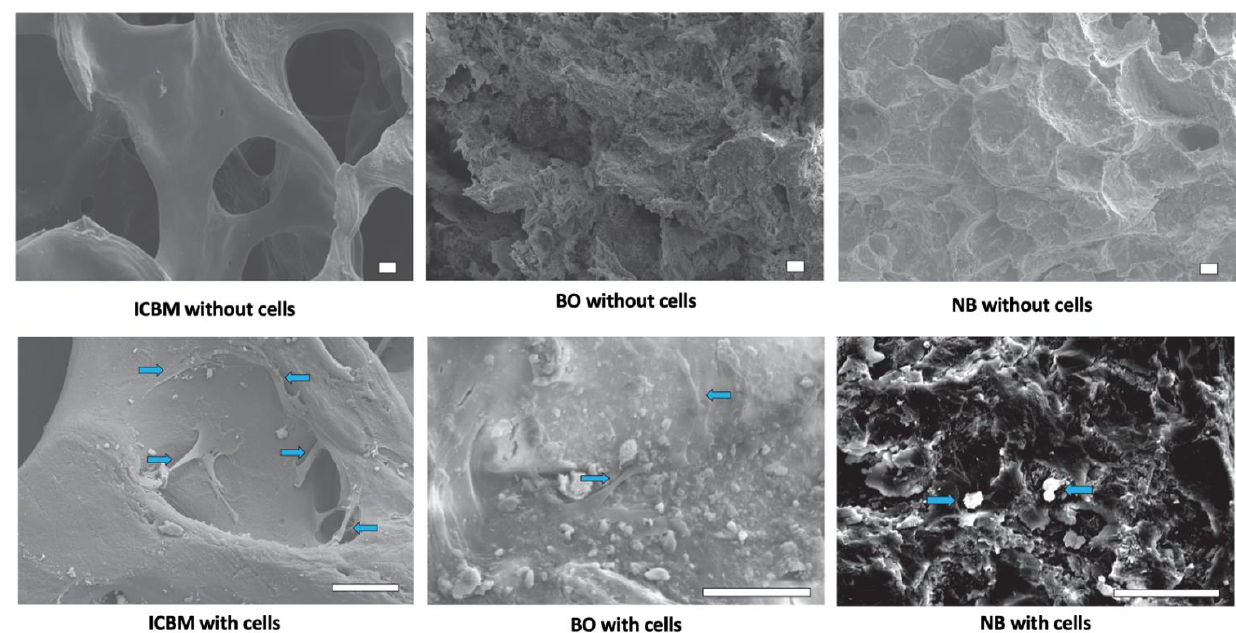
Figure 2. Scanning electron microscope images of the different carriers. In the upper panel, the carriers are displayed before cultivation with unrestricted somatic stem cells (USSCs). The lower panel shows the different carriers after 7 days of cultivation. USSCs in different shapes and sizes are visible (blue arrows). On the ICBM carrier cells show long ciliae as a sign of increased migratory activity. (white bar = 100 µ m, upper panel farther away to gain a structural overview, lower panel zoomed in closer in order to detect and evaluate cells).